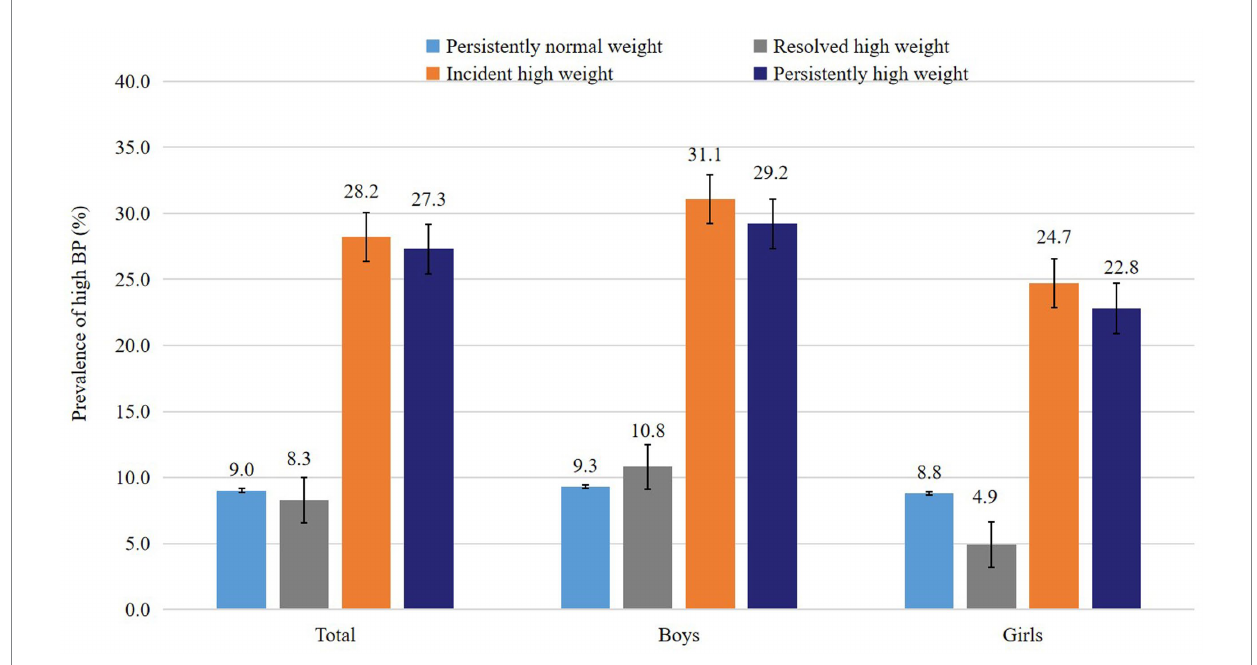
FIGURE 1 Prevalence of high BP across different weight status change